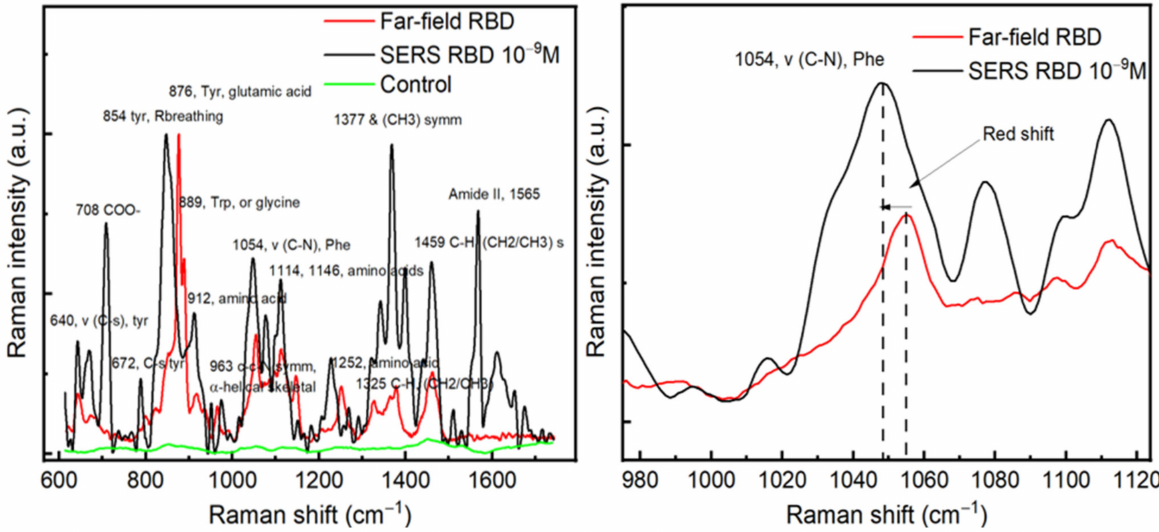
Figure 4. ( a ) A comparison between SERS and far-field of RBD, the green curve represents the Raman spectrum carried out on the Au/Ag substrate (control) without RBD proteins. ( b ) A zoom in on the peak position located around 1050 cm − 1 , a red shift is observed between SERS and Far-field